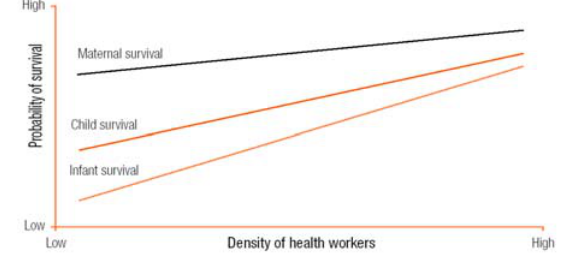
Figure 6: Relationship between the probability of survival and density of the health workers: “HEALTH WORKERS SAVE